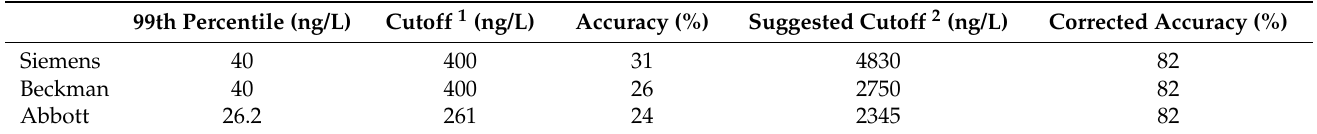
Table 7. Cutoff values and accuracy of the assays for MI type